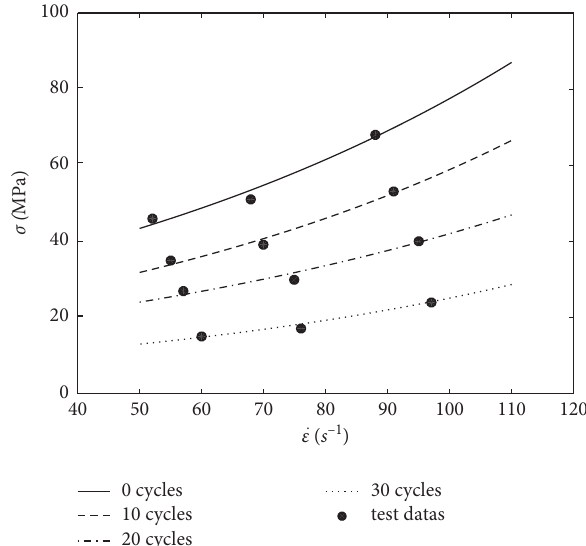
Figure 14: Relationship between strain rate and strength of samples with different freeze-thaw cycles under the axial pressure of 5MPa.